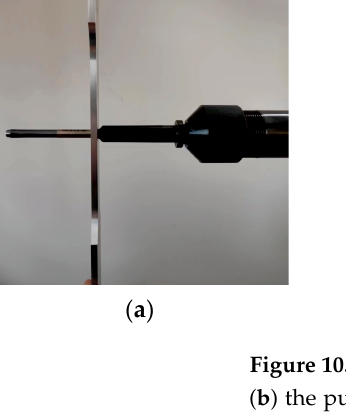
Mises stress extruded from a single hole without a hidden split sleeve; ( b ) equivalent von